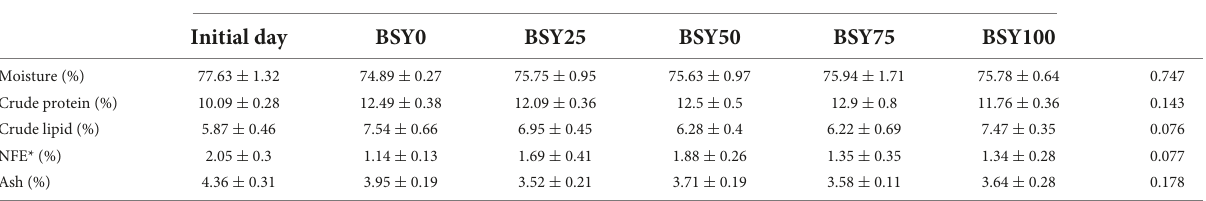
TABLE 3 Whole-body chemical composition (%) of climbing perch fingerlings to the BSY incorporated diets for 60 days. Treatments P-value Initial